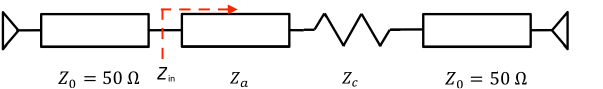
Figure 10. Simplified transmission line model of MEMS switch at the ON state.